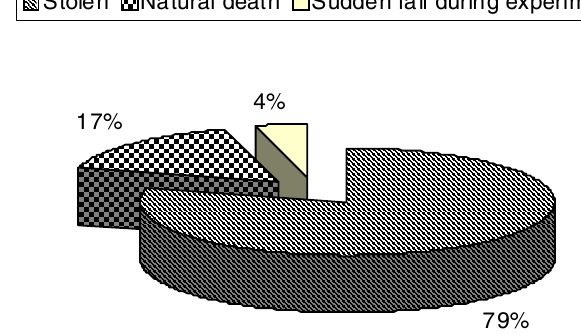
Figure 1. Loss of eggs